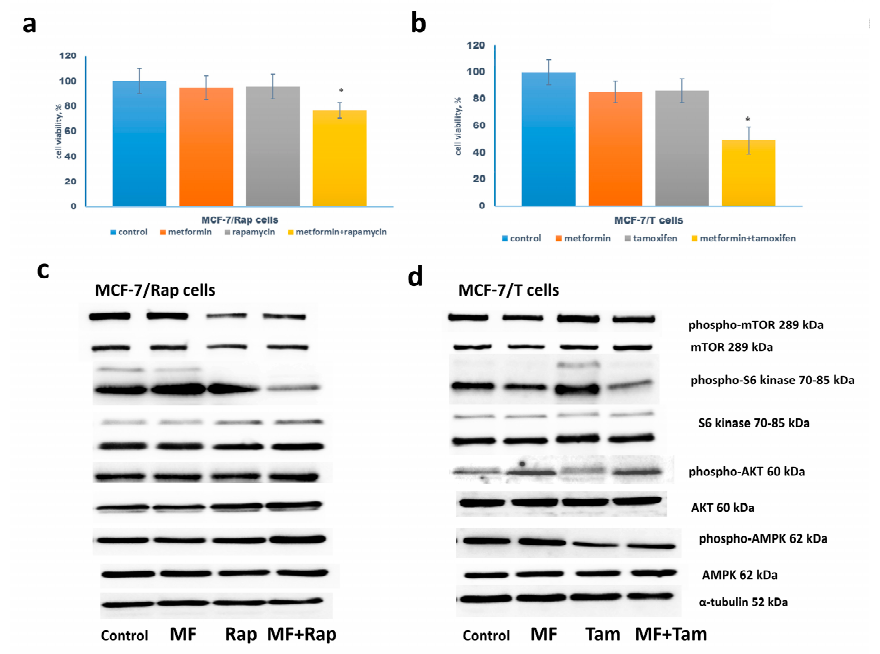
Figure 3. Drug sensitivity of MCF-7 / Rap and MCF-7 / T cells. ( a , b ) Cell growth. The MCF-7 / Rap cells were treated without or with 1 µ M rapamycin in the presence or absence 2 mM metformin (MF) (a), the MCF-7 / T cells—with 5 µ M tamoxifen (Tam) and / or 2 mM metformin (b) for 3 days in standard DMEM medium with 10% FBS, and the amount of the viable cells was counted by the MTT test; Data represent mean value ± SD of three independent experiments. One-hundred percent was set as the viability of cells treated with vehicle control. p < 0.05: * versus control and either drug alone. ( c , d ) Western blot analysis. The MCF-7 / Rap and MCF-7 / T cells were treated as indicated above. Western blot analysis of AMPK, phospho-AMPK, mTOR, phospho-mTOR, S6 kinase, phospho-S6 kinase, Akt, phospho-Akt was performed in the cell extracts. Protein loading was controlled by membrane hybridization with α -tubulin